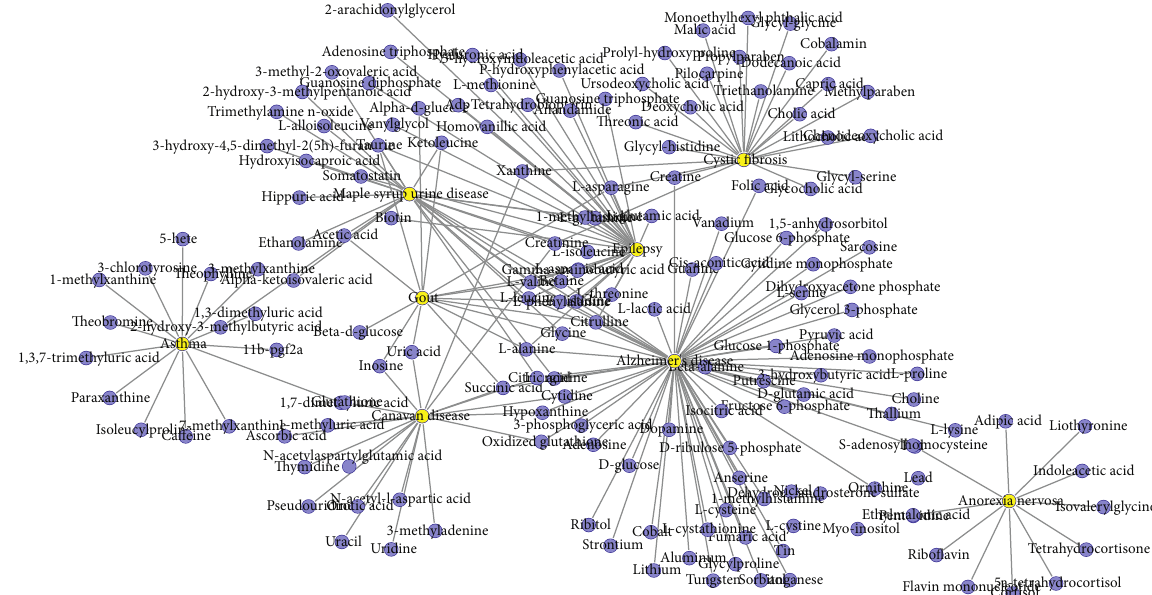
Figure 2: A part of the known metabolite-disease associations network. Yellow nodes represent diseases, and purple nodes represent